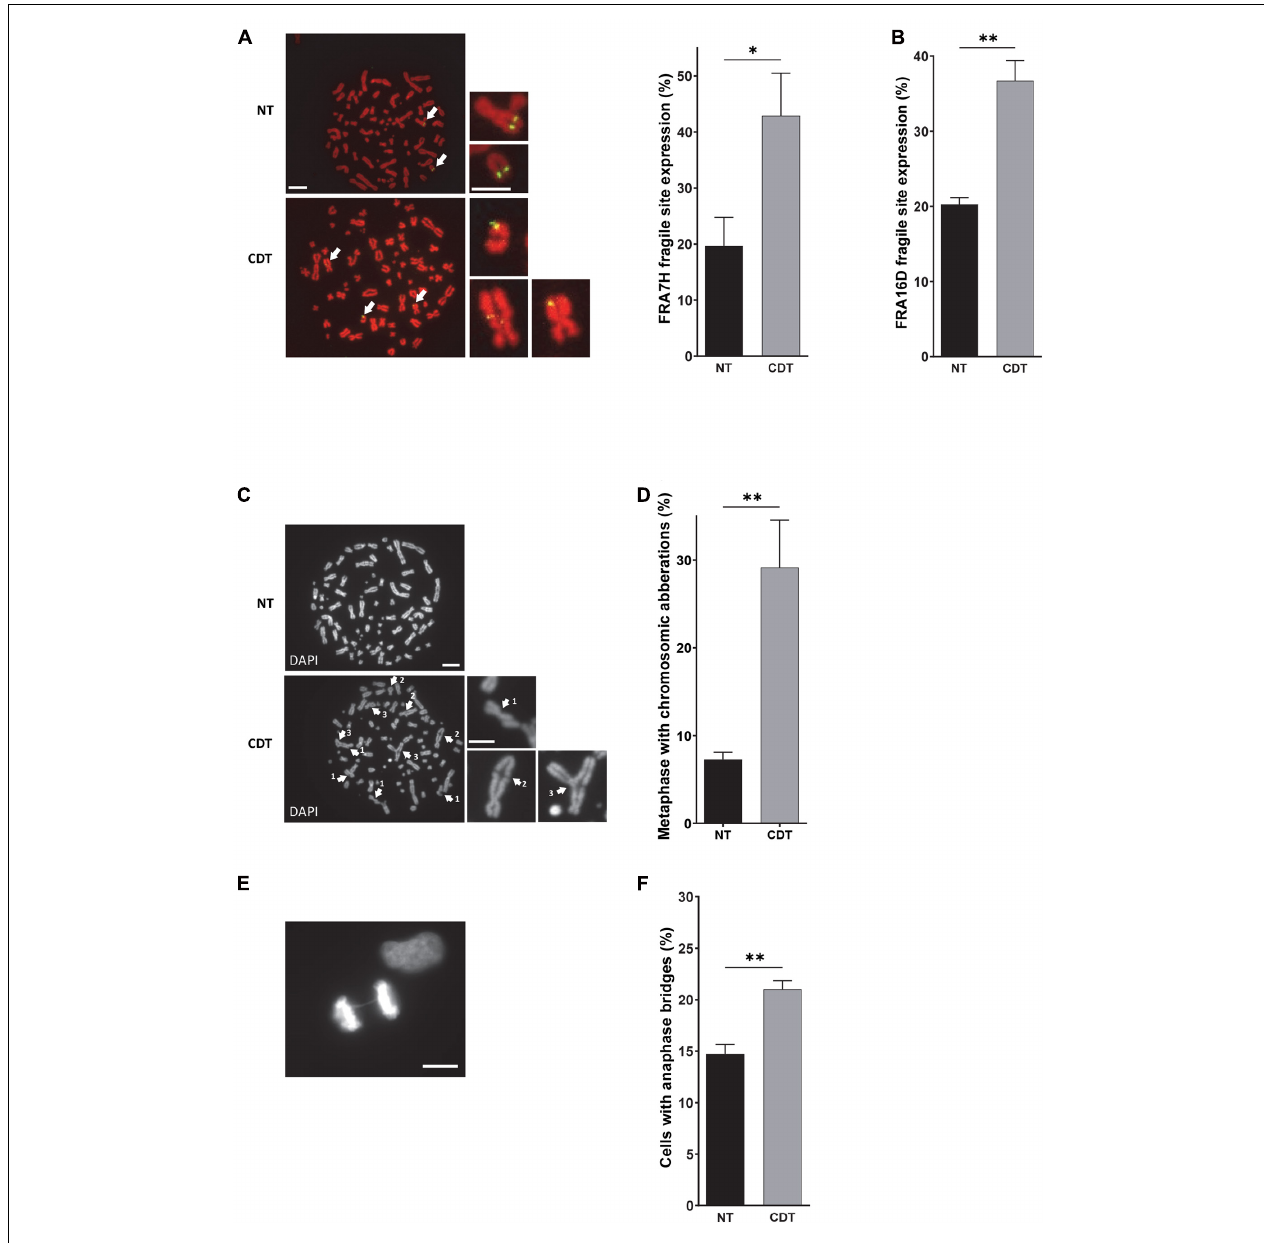
FIGURE 3 | CDT induces the expression of fragile sites, global chromosomic aberrations, and anaphase bridges. (A) Illustration and quantification of metaphases with the expression of the common fragile site FRA7F (green) analyzed by fluorescence in situ hybridization (FISH) in U2OS cells treated or not with 250 pg/ml of CDT from E. coli (CDT). The chromosomes were stained with DAPI (red). Images were obtained with a wide-field fluorescent microscope. N > 30 metaphases, scale bar: 10 µ m (5 µ m, chromosome magnification). (B) Quantification of metaphases with the expression of the common fragile site FRA16D analyzed by FISH in U2OS cells treated or not (NT) with E. coli CDT (CDT) for 53 h. Illustration (C) and quantification (D) of metaphases containing at least one chromosomic aberration in U2OS cells treated or not (NT) with 250 pg/ml of CDT from E. coli (CDT) during 53 h. The chromosomes were stained with DAPI (grayscale). Images were obtained with a wide-field fluorescent microscope. N > 60 metaphases; white arrows indicate chromosomal abnormalities such as DNA break (1), end-to-end fusion (2), and triradial chromosomes (3). Scale bar: 10 µ m (5 µ m, chromosome magnification). Representative image of DAPI (grayscale) staining (E) and quantification (F) of anaphases with DNA bridge in HeLa cells treated or not (NT) with 100 pg/ml of CDT from E. coli (CDT) for 24 h. N > 90 anaphases were analyzed with a wide-field fluorescent microscope. Scale bar: 10 µ m (mean ± SEM of at least three independent experiments) [ ∗ P < 0.05, ∗∗ P < 0.01, versus non-treated (NT)].